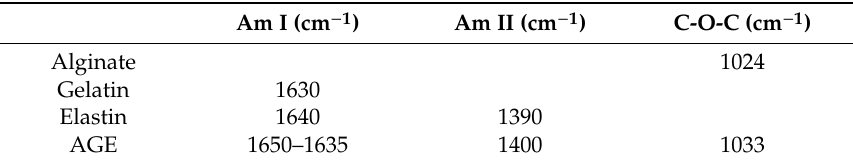
Table 4. Fourier transformed infrared spectroscopy (FT-IR) analysis. Wavelength displacements in AGE sca ff olds for the typical absorption bands of alginate, gelatin, and elastin.